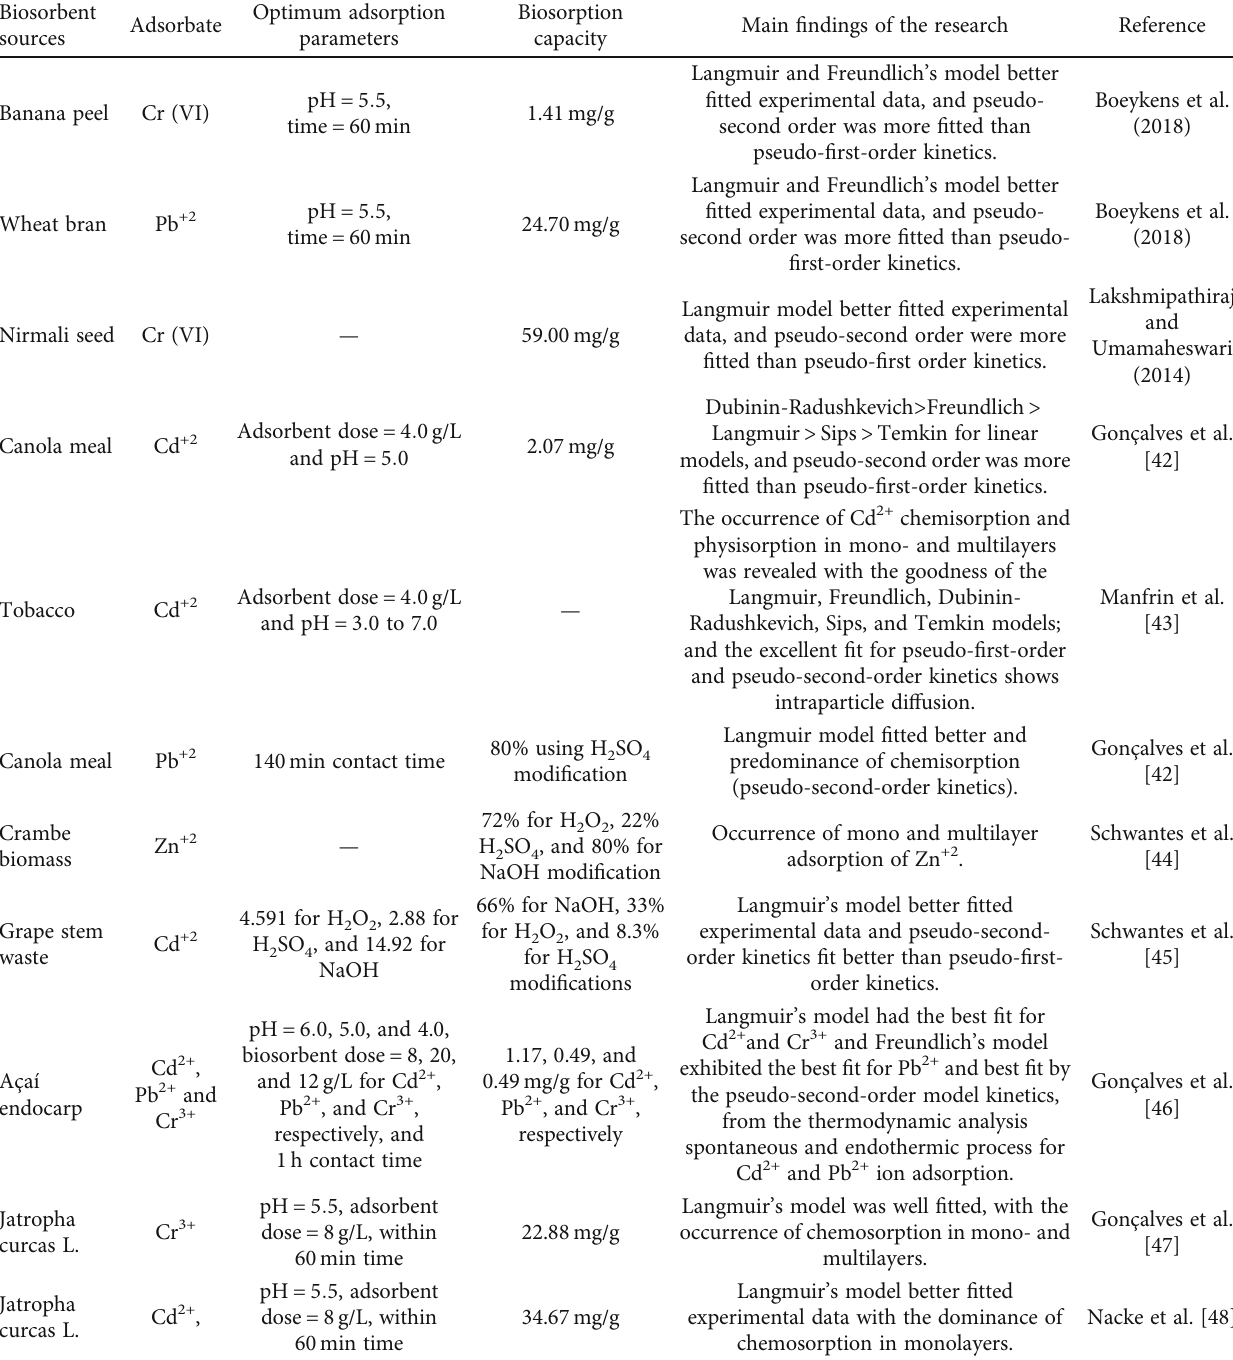
Table 5: Summary of literature values for adsorption of metal ions using various biosorbent